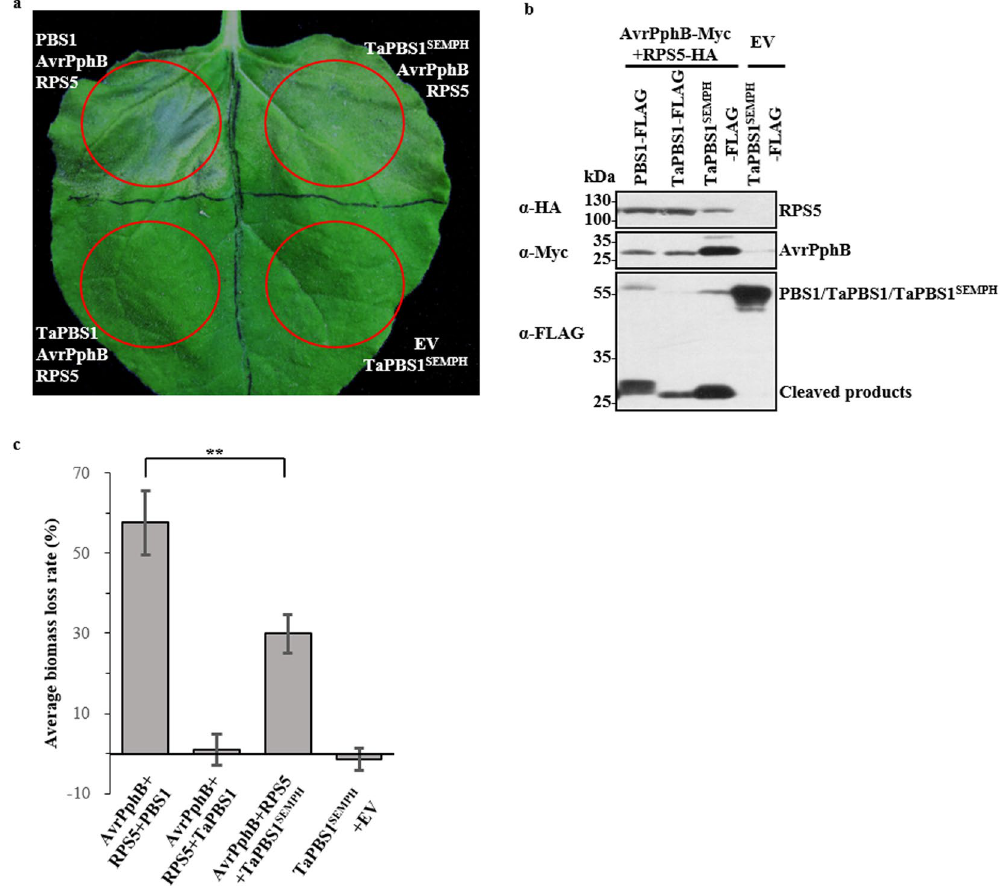
Figure 6. The introduction of the SEMPH motif into TaPBS1 enables it to activate RPS5 in transient assay. ( a ) The replacement of the STRPH motif with the SEMPH motif in TaPBS1 resulted into the RPS5-mediated HR in N . benthamiana following the cleavage of TaPBS1 SEMPH by AvrPphB. TaPBS1 or TaPBS1 SEMPH was co-expressed with RPS5 and AvrPphB in N . benthamiana leaves. HR assays were performed as above. ( b ) The protein expression control for the above assays. ( c ) Quantification of HRs induced in N . benthamiana leaves. HR was quantified by measuring the biomass loss rate of N . benthamiana leaves infiltrated with A . tumefaciens carrying indicated constructs. Results are the means ± SD of three independent repeats. Statistical significance was determined using a Student’s t -test: ** P <